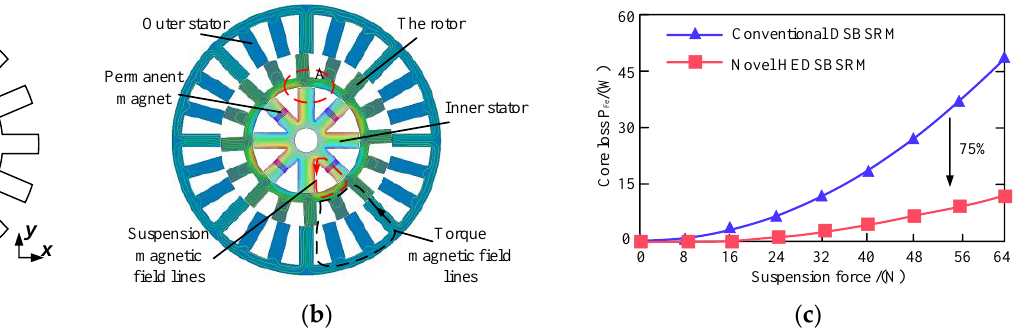
Figure 10. Hybrid excitation double stator BSRM: ( a ) Suspension force generation; ( b ) Motor topology; and ( c ) Comparison of core loss.